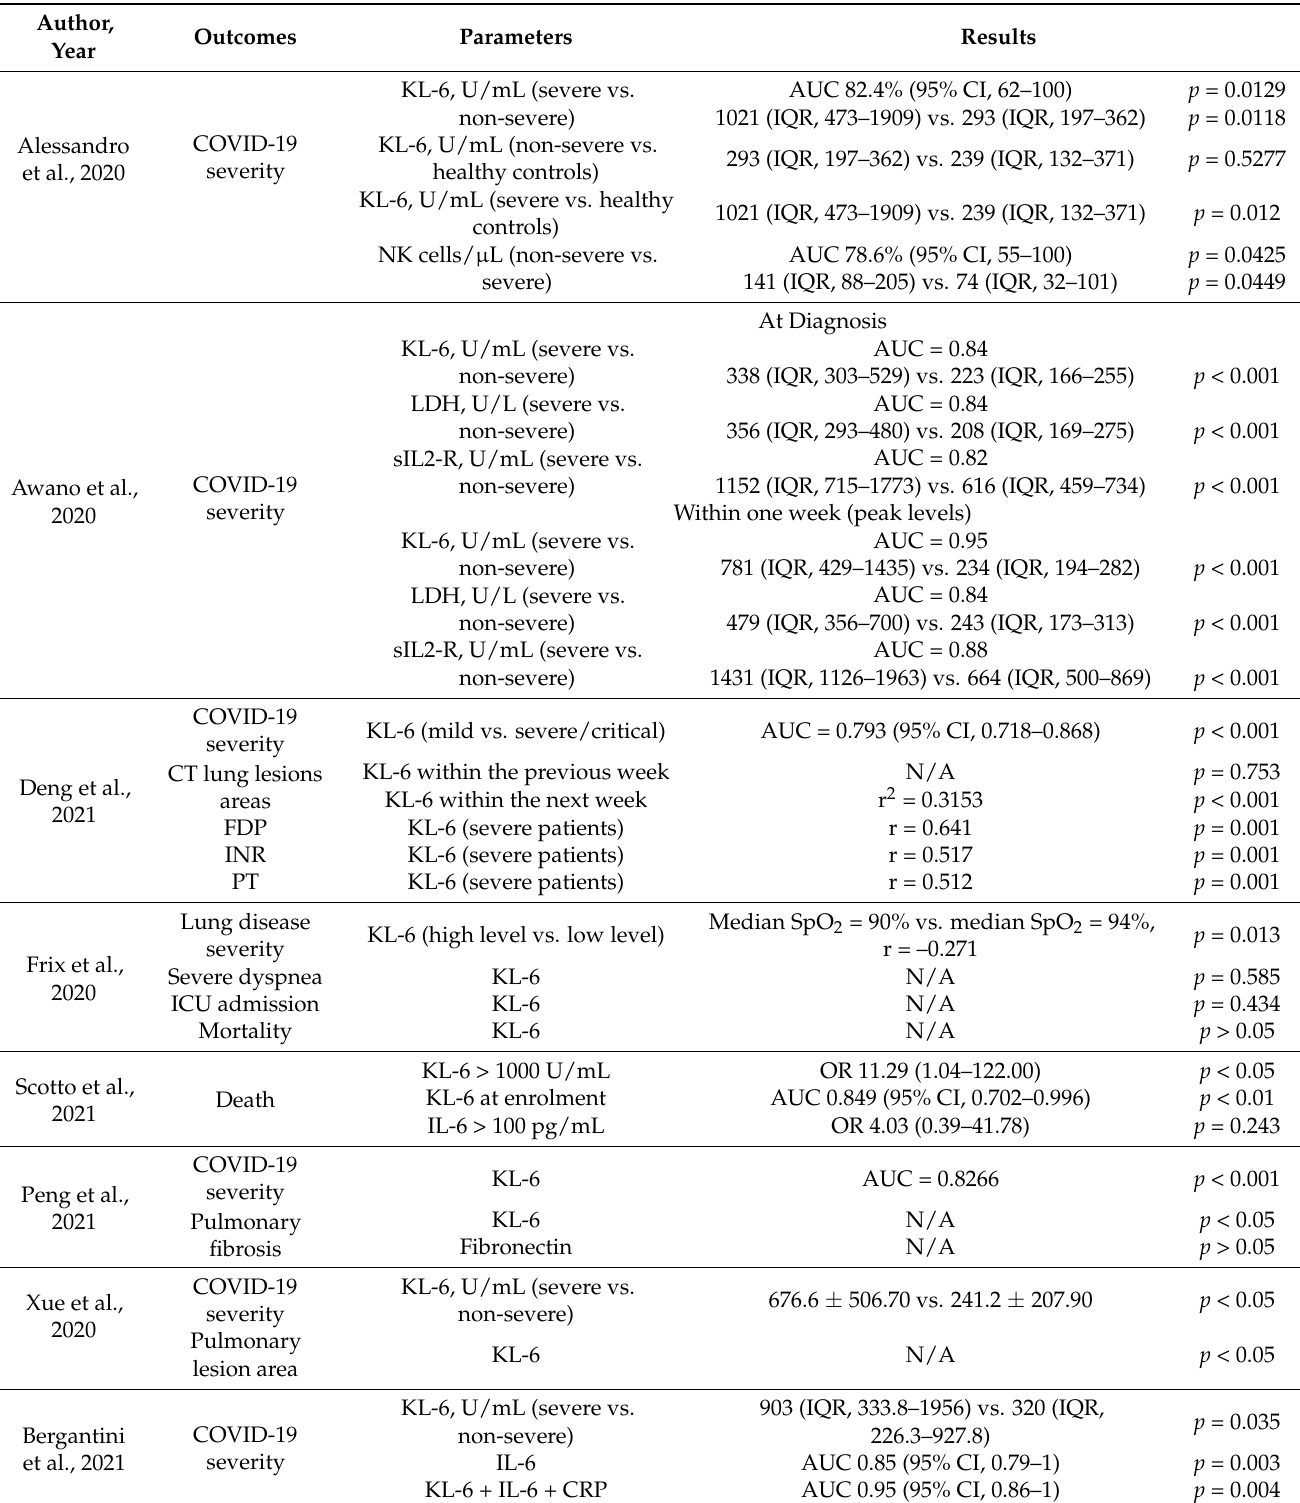
Table 2. Results reported in clinical